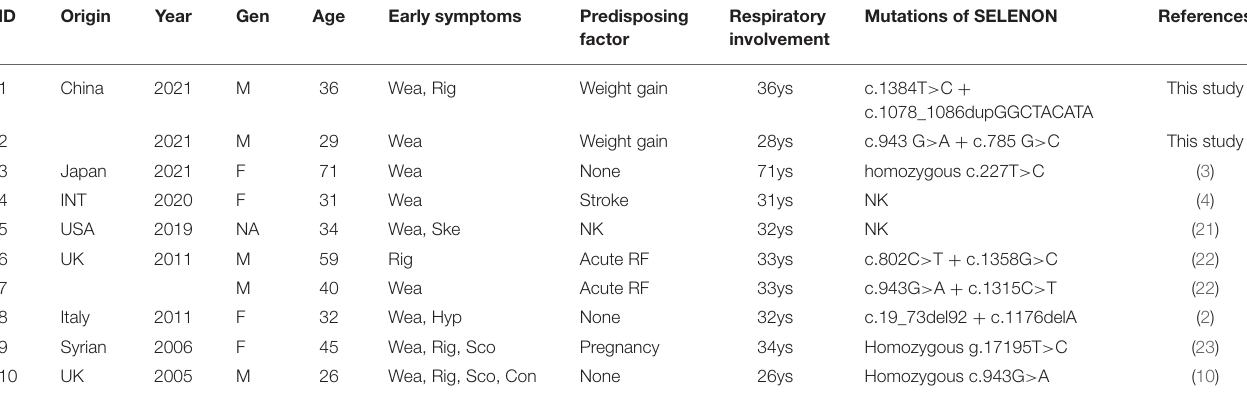
TABLE 3 | Delayed respiratory insufficiency in patients with